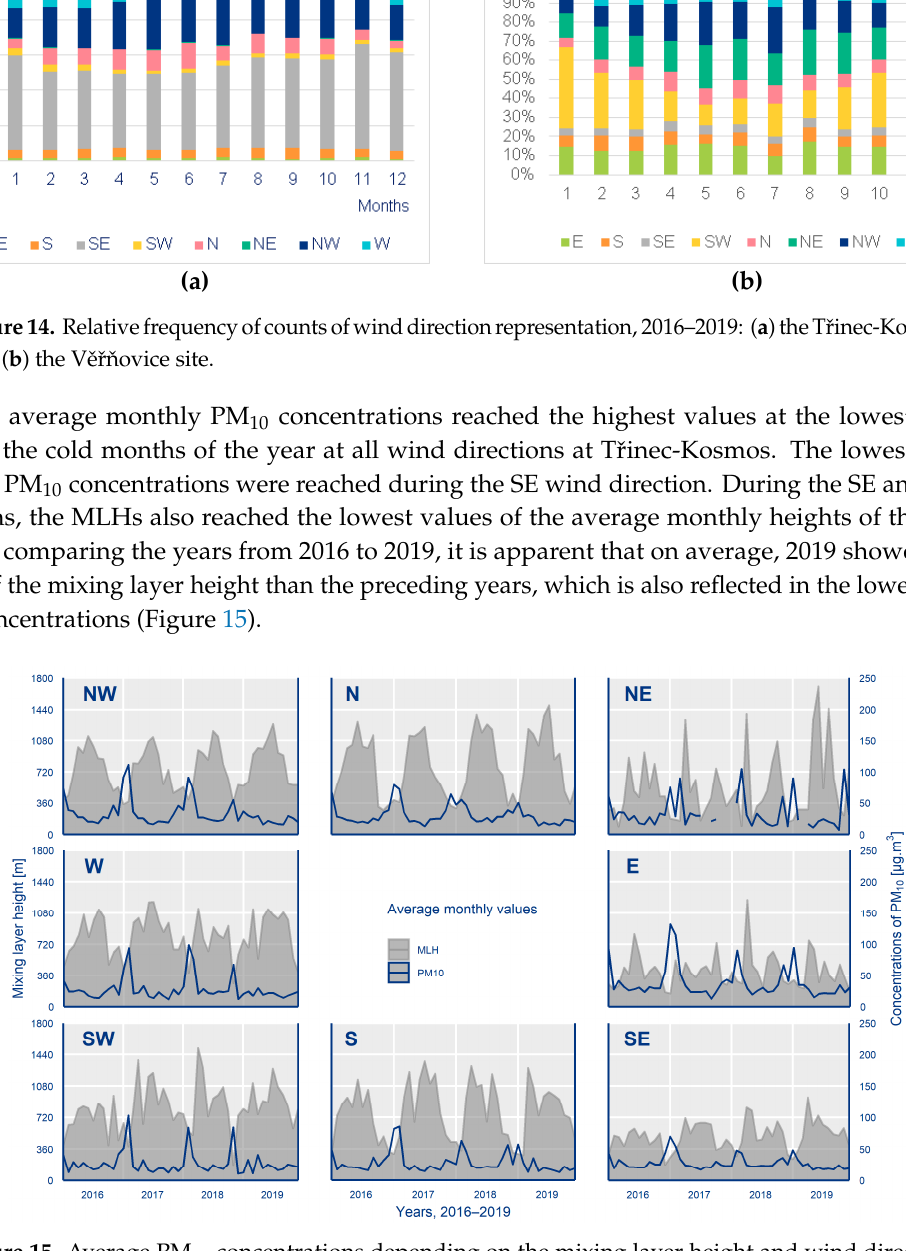
Figure 15. Average PM 10 concentrations depending on the mixing layer height and wind direction, the T ř inec-Kosmos site, 2016–2019.